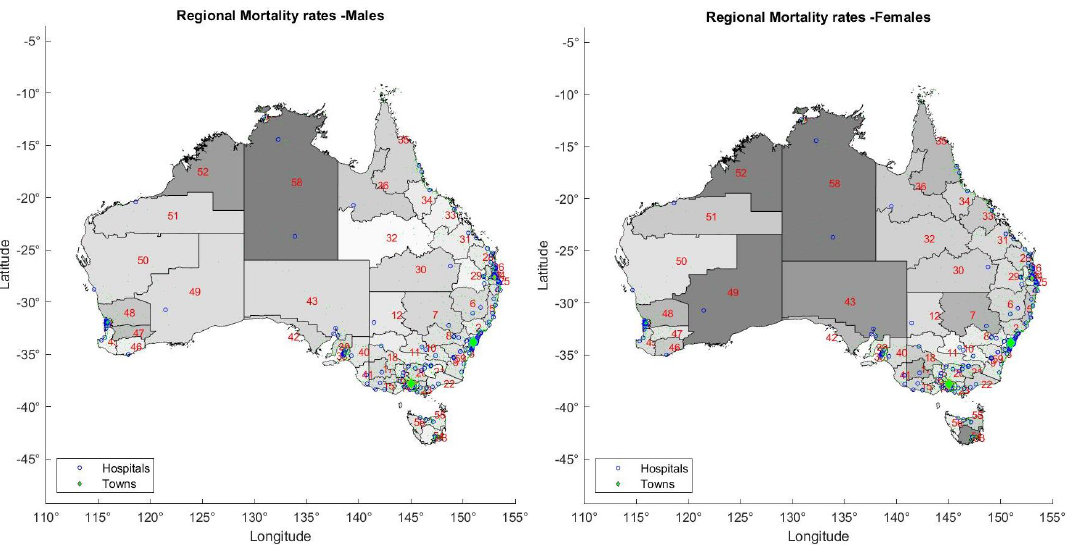
Figure 4. Regionalized mortality rates—by